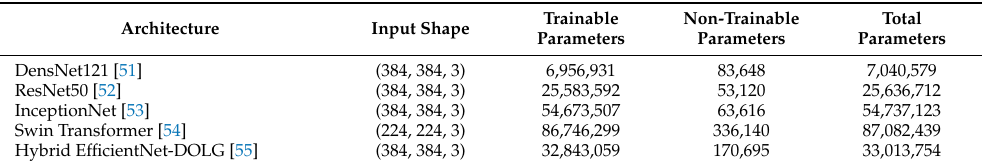
Table 3. Detailed description of the five deep learning models used in this paper.